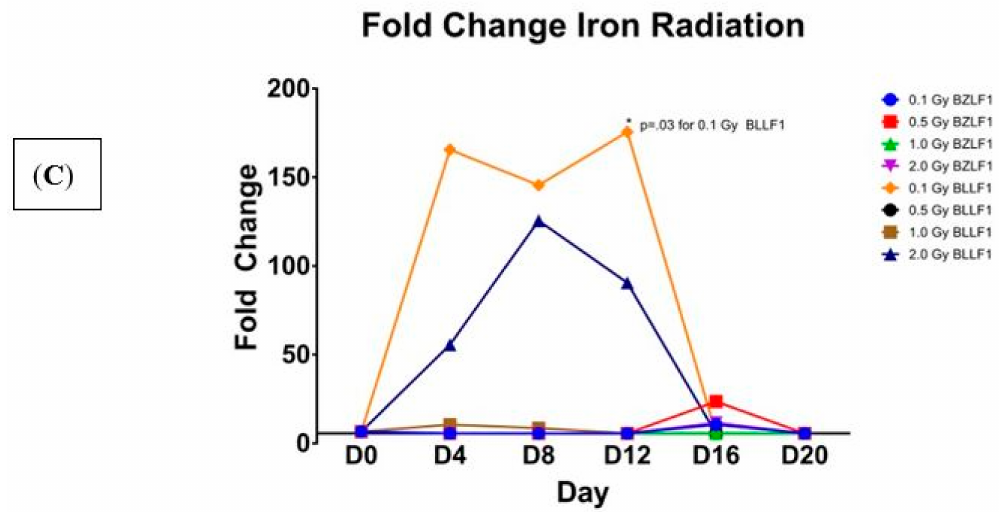
Figure 2. Fold change in EBV BZLF1 and BLLF1 transcripts over time at various amounts of the three types of radiation, relative to the un-irradiated control. The x axis shows the time point, measured in days, -post-radiation treatment. The y axis shows the fold change in BZLF1 and BLLF1 transcripts. BZLF1 and BLLF1 transcript quantity values divided by the corresponding GAPDH quantity values, with fold change being relative to the un-irradiated controls. Statistical significance as compared to no radiation control (two-tailed t test, * p < 0.05). ( A ) Proton; ( B ) carbon, ( C )